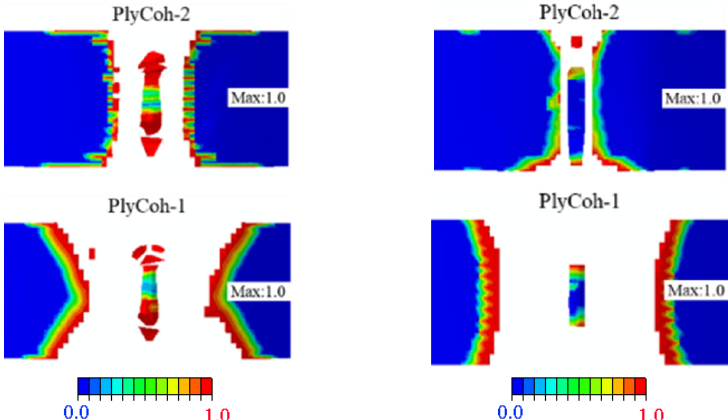
Figure 21. The final interlayer damage patterns: ( a ) 2D Hashin model; ( b ) 3D Hashin model.